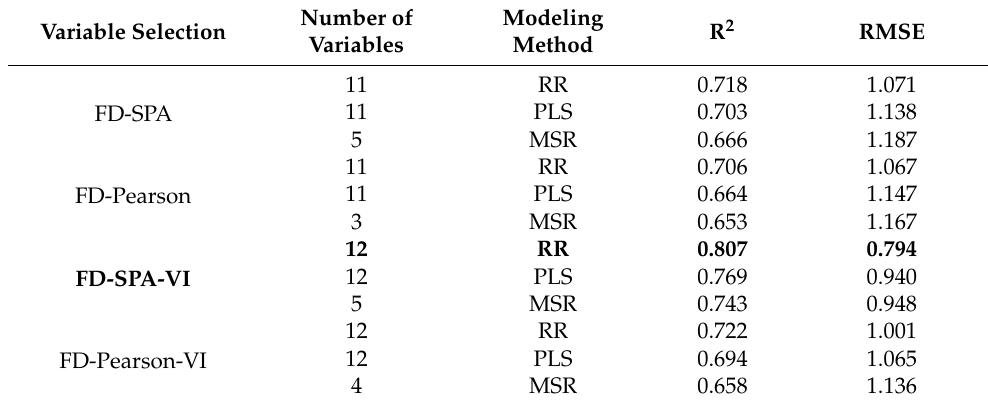
Table 4. Modeling based on the selection of different independent variables with LAI. The total number of samples for LAI was 120, 60 modeling sets and 60 validation